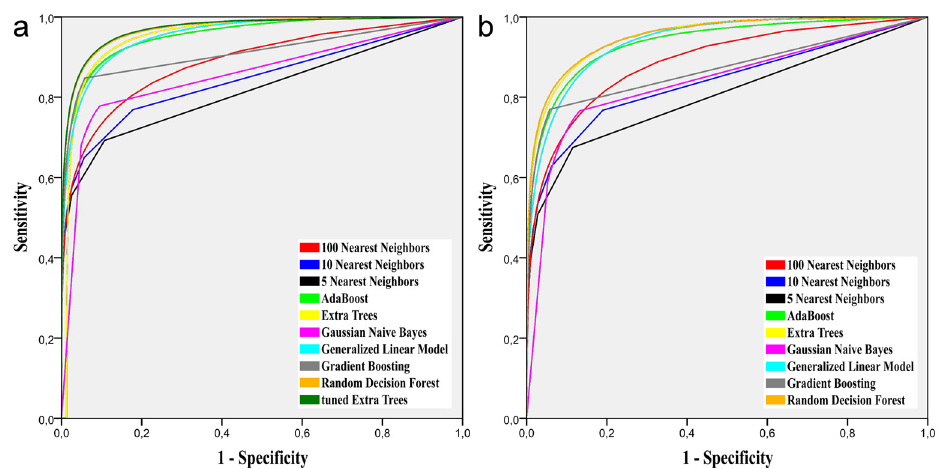
Fig 4. ROC curves for both evaluation scenarios computed over the GTG ground truth. (a) besteffort scenario. (b) flair scenario.